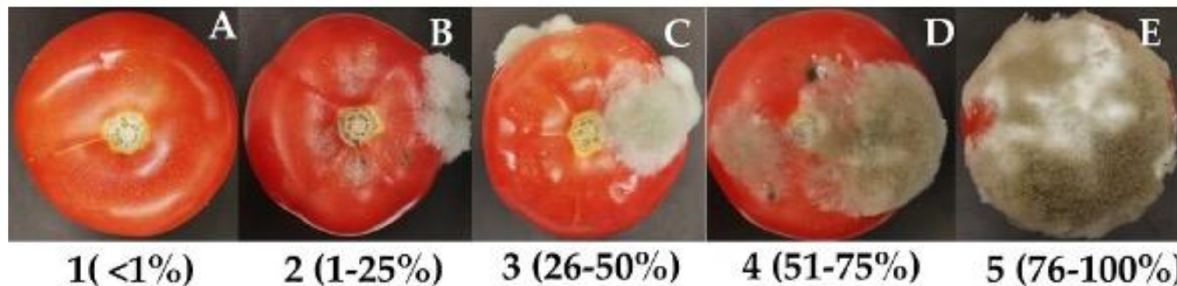
Figure 5. Visual scale (1–5) of symptoms caused by B. cinerea to quantify the incidence and severity of the disease on tomatoes: ( A ) 1 = There are no visible symptoms (not infected); ( B ) 2 = 1–25% of the inoculated area is covered with a slight necrotic mycelium (mild Infection); ( C ) 3 = 26–50% of the inoculated area is covered with necrotic mycelia (moderate Infection); ( D ) 4 = 51–75% of sample are necrotic with appeared spore masses (strong Infection); ( E ) 5 = 76–100% of the necrotic tissue appears soft and decays with a fungal mass (very Severe